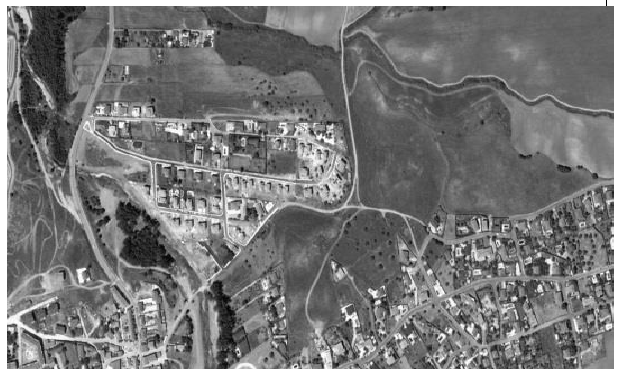
Figure 17. Quijorna. Madrid, Spain before 2007 crisis.